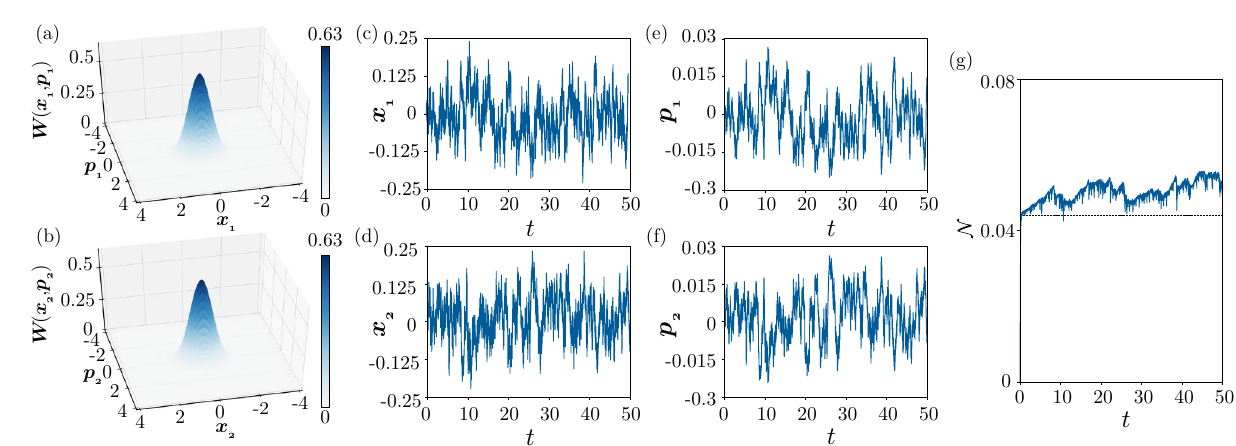
Figure 9. Turing instability under continuous quantum measurement in the strong quantum regime. ( a , b ) 50 . ( c , d , e , f ) Time evolution of 3D snapshot plots of the Wigner distributions W ( x 1 , p 1 ) and W ( x 2 , p 2 ) at t = p 1 x 1 x 2 the average values of the position and momentum operators for two units: ( c ) , ( d ) , ( e ) , and ( f ) (cid:31) (cid:30) (cid:31) (cid:30) (cid:31) (cid:30) 0.3 , 0.6, γ 1 6.2, γ 2 3, θ π , η p 2 . ( g ) Time evolution of the negativity N . The parameters are � = (cid:31) (cid:30) = − = = = 1 ( D 0.005 and D 1, 2 . In ( f ), the black 0.995 ), and φ 0 and κ 0.25 for both j 0.99 , D D h c = x = p = j = j = = = − line represents the value for the steady state of the system without performing